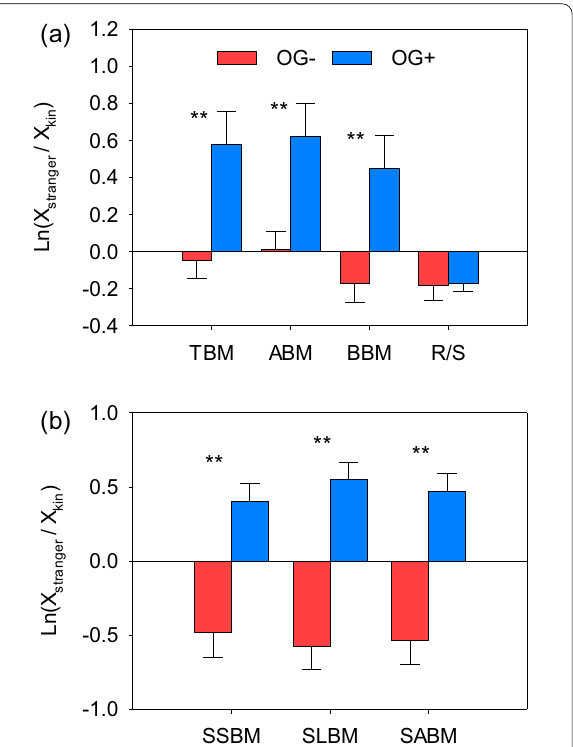
Fig. 4 Effects of historical grazing on the ln-based response ratios (i.e., ln (X stranger /X kin )) of biomass production to neighbor identity at the population ( a ) and ramet ( b ) levels in Leymus chinensis offspring. TBM, total biomass; ABM, aboveground biomass; BBM, belowground biomass; R/S, root–shoot ratio of biomass; SLBM, leaf biomass of Fig. 3 Sensitivity comparison of log response ratios (LRR, i.e., ln single plant; SSBM, stem biomass of single plant; SABM, aboveground (X stranger /X kin )) to maternal effect for 13 indicators in Leymus chinensis biomass of single plant; OG-, offspring of L. chinensis that have not offspring. a Descending order of LRRs in OG plants. b Ascending − experienced grazing, OG , offspring of long-term overgrazed L. order of LRRs in OG plants. c Relationship between LRRs in + + chinensis . ** P < 0.01 OG and OG L. chinensis offspring. OG , clonal offspring of L. − + − chinensis that have not experienced grazing, OG , clonal offspring + of long-term overgrazed L. chinensis . PN, net photosynthetic rate, TN, tiller number; RL, root length; SBM, stem biomass; ABM, aboveground biomass; BBM, belowground biomass; TBM, total biomass; LBM, leaf biomass; SSBM, single of stem biomass; SABM, single of aboveground biomass; SLBM, single of leaf